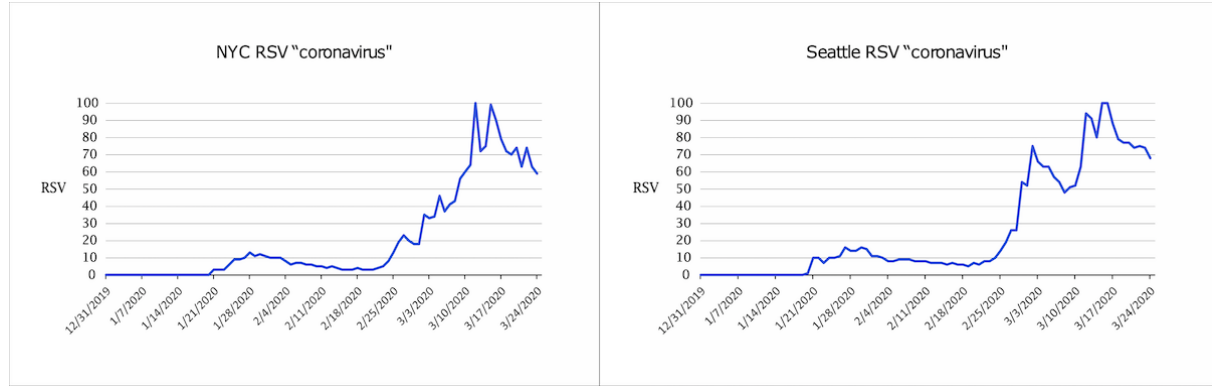
Figure 2. Google Trends RSV (0-100) of the keyword coronavirus in New York City, NY and Seattle-Tacoma, WA from December 31, 2019 to March 24, 2020. RSV: relative search volume.